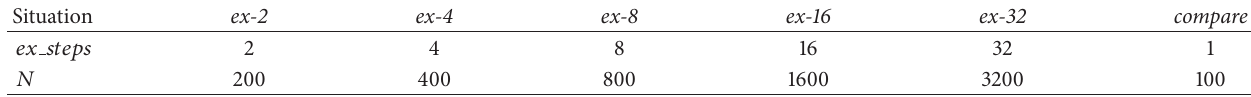
Table 10: Parameter list of different data exchanging times and sampling numbers.